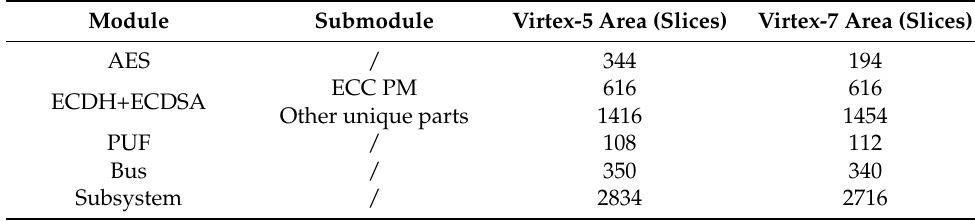
Table 3. Image encryption subsystem resource usage results under FPGA